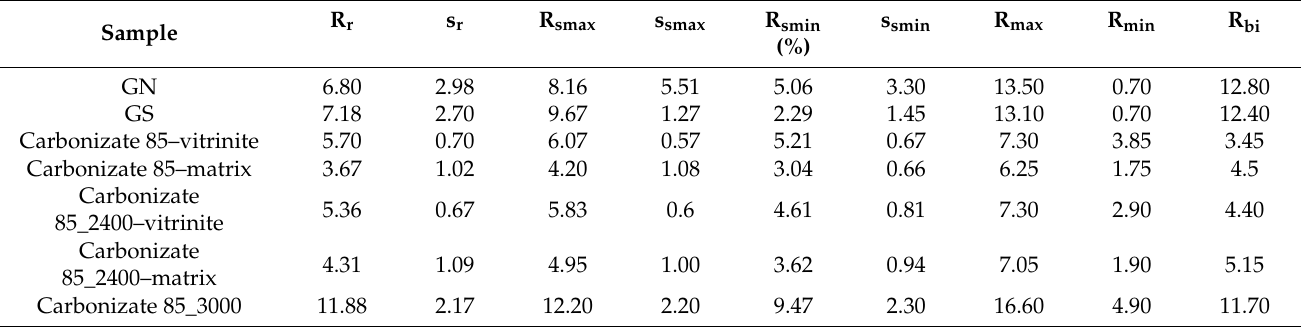
Table 1. Results of reflectance